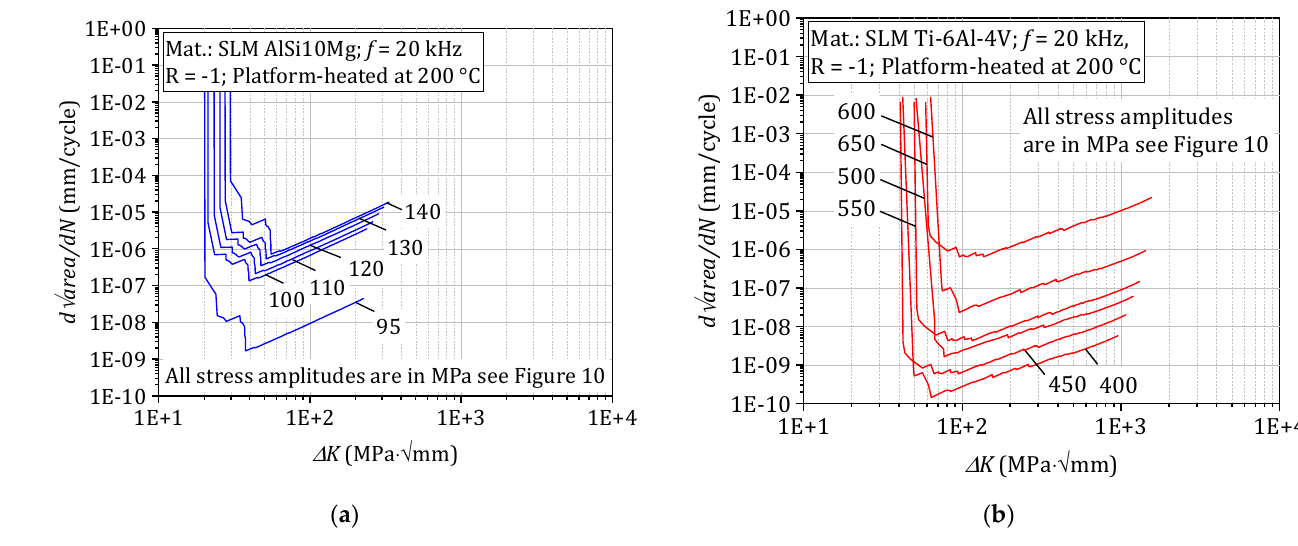
Figure 11. Crack propagation rates at 20 kHz: ( a ) AlSi10Mg and ( b ) Ti-6Al-4V.